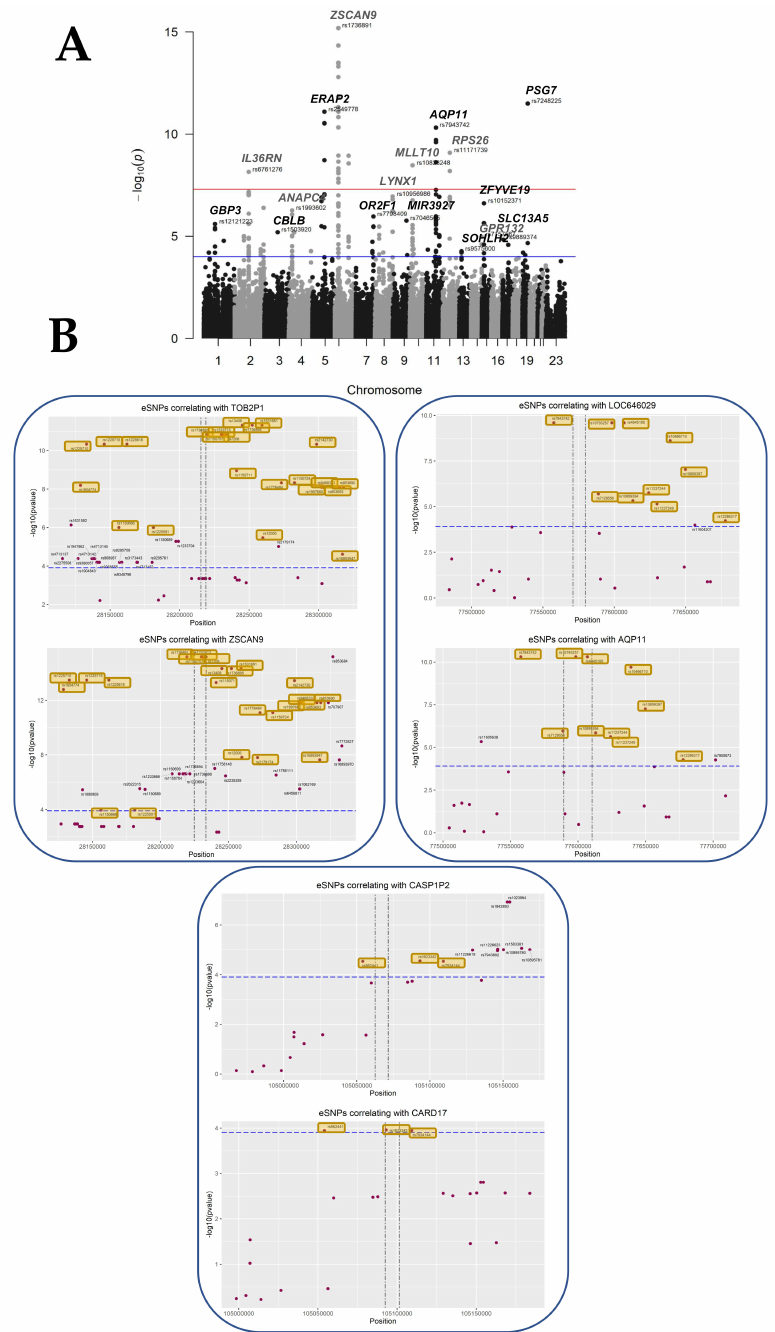
Figure 3. Overview of the cisQTL results for the ALL COVARIATES dataset. ( A ) Manhattan plot showing each tested SNP as a dot in its genomic position on the x-axis, stratified by chromosomes. The y-axis expresses the -LOG10 of the p -value of the interaction with the eGene. Suggestive line in red shows the 10 × 10 − 8 threshold, while in blue, the threshold corresponding to a p -value of 0.05 adjusted for the number of tests (False Discovery Rate) = 1.24 × 10 − 4 . ( B ) Plots showing the localization of the tested SNPs within the genomic regions on chromosome 6, containing ZSCAN9 and TOB2P1, and chromosome 11, where AQP11, LOC646029, CASP1P2, and CARD17 are located. The x-axis expresses the genomic coordinates, while in the y-axis, the -LOG10 of the p -value, the horizontal line sets the level for FDR ≤ 0.05. The vertical lines represent the start and end sites for each of the genes. eSNPs that were found to be in common between eGenes in the same region are highlighted in